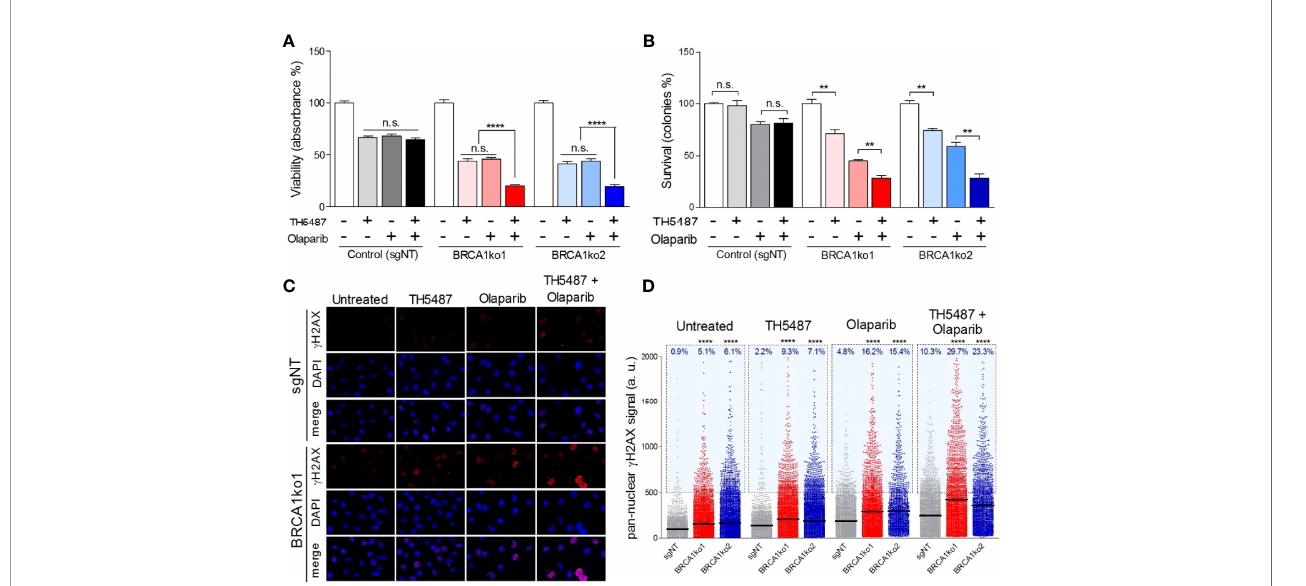
FIGURE 3 | OGG1 inhibition enhances the sensitivity to olaparib in BRCA1-de fi cient MDA-MB-231 cells. (A) Cell viability assessment using MTT displaying proliferation changes of BRCA1-pro fi cient (sgNT) and de fi cient (BRCA1ko1 and BRCA1ko2) MDA-MB-231 cells after single-drug (TH5487 3.75 µM or olaparib 0.5 µM) or combined treatments for 72 hours. (B) Clonogenic survival of BRCA1-pro fi cient (sgNT) and de fi cient (BRCA1ko1 and BRCA1ko2) MDA-MB-231 cells exposed to TH5487 (3 µM), olaparib (30 nM), or a combination of both inhibitors. (C) Immuno fl uorescent staining of g H2AX. A representative confocal image example of one of three independent experiments is shown for control (sgNT) and BRCA1ko1 cells for each treatment condition. Cells were stained for g H2AX (red) and DAPI (blue) was used to stain cell nucleus. (D) Pan-nuclear g H2AX signal intensity of BRCA1-pro fi cient (sgNT) and de fi cient (BRCA1ko1 and BRCA1ko2) MDA-MB-231 cells exposed to TH5487 (3.75 µM), olaparib (0.5 µM), or a combination of both. In (A, B) values are normalized to untreated cells (DMSO) and bars represent the mean and the SEM of at least three independent experiments. In (D) each dot represents the signal from one cell, horizontal lines indicate mean values, and the blue area delineates cells above an arbitrarily chosen threshold (500 arbitrary units of pan-nuclear g H2AX signal intensity). Each condition includes at least 2000 cells from 3 independent experiments. Unpaired t ‐ tests were used in (A, B) . In (D) statistical signi fi cance was determined by Mann-Whitney U tests. **p-value<0.01 and ****p- value<0.0001. ns, not signi fi